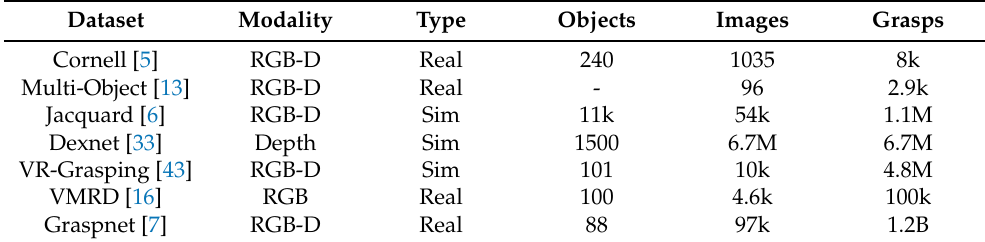
Table 2. Summary of antipodal robotic grasping